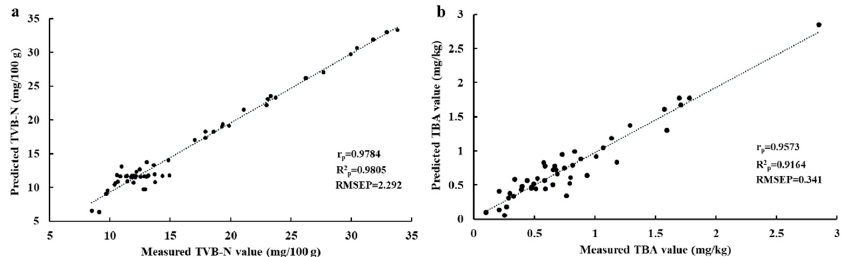
Figure 3. Scatter plots of predicted versus measured TVB-N ( a ) and TBA ( b ) obtained by FNN- simplified model based on the optimal wavelengths.